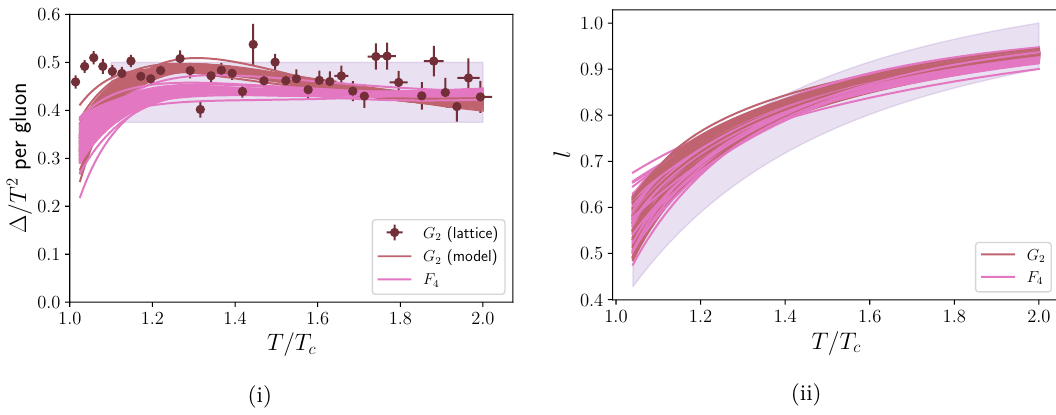
Figure 4. Resulting fits for the model given in eq. (3.12) in the case of G 2 and F 4 gauge groups, showing the interaction measure and Polyakov loop curves obtained for different choices of q c and q t that best reproduce the lattice data available for G 2 or the expected regions shown in